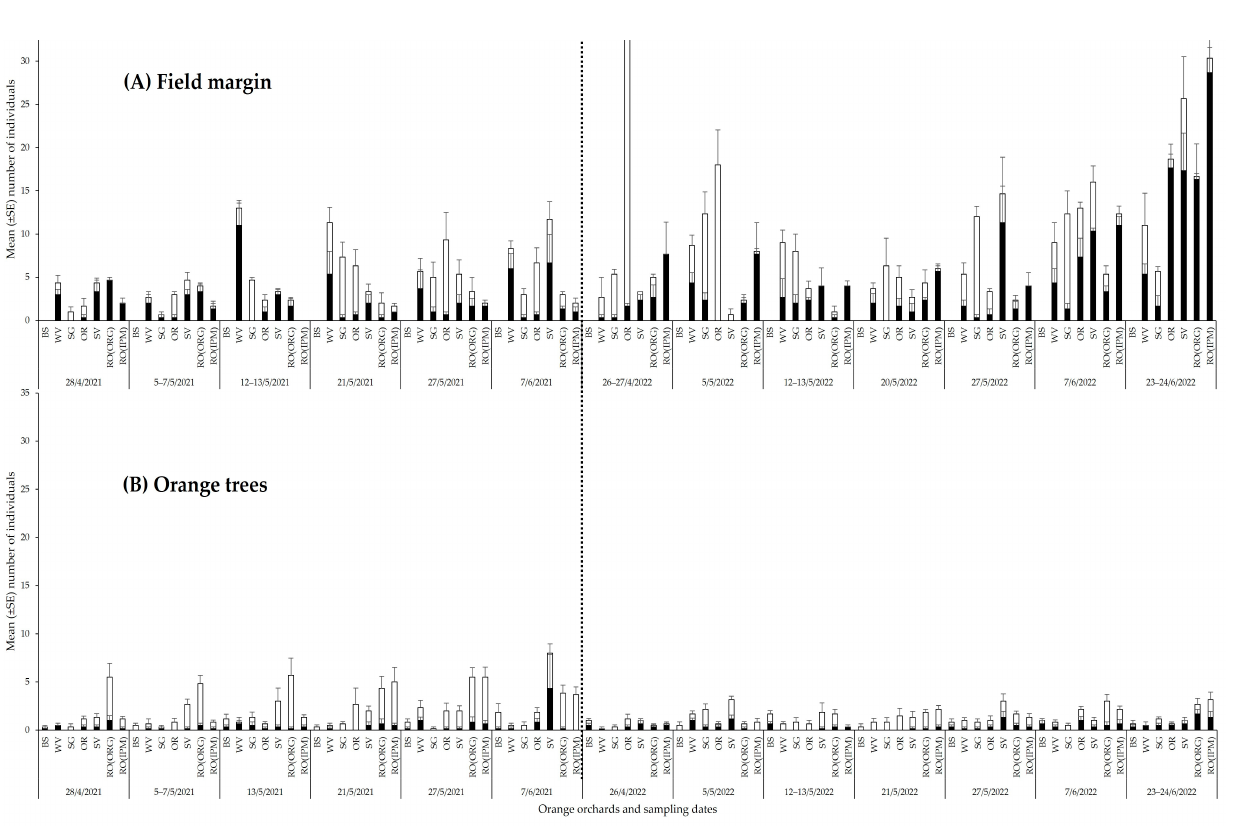
Figure 8. Temporal distribution of arachnid and insect predators ( A ) in field margins, ( B ) on orange trees in orchards with different field margin management: BS—bare soil; WV—weed vegetation; RO(ORG)—rosemary hedgerow (organic orchard); RO(IPM)—rosemary hedgerow (IPM orchard); OR—oregano hedgerow; SG—sage hedgerow; SV—savory